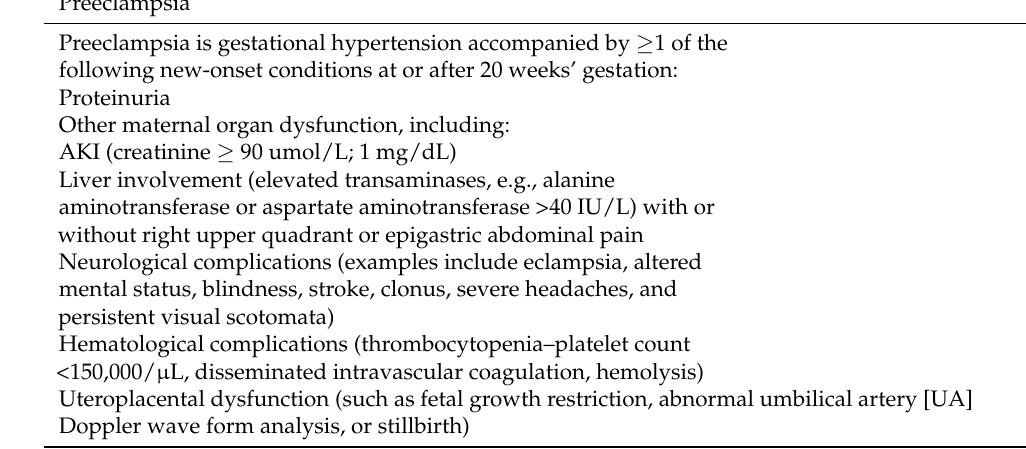
Table 11. Preeclampsia diagnostic criteria formed by International Society for the Study of Hyperten- sion in Pregnancy (ISSHP) in